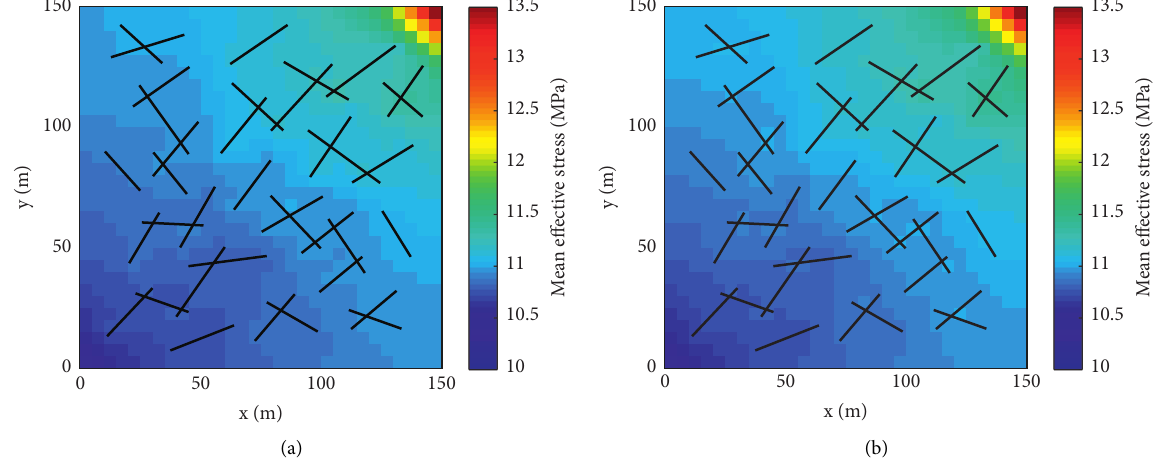
Figure 27: Mean effective stress profiles for (a) pIEDFM and (b) EDFM after 20000days of